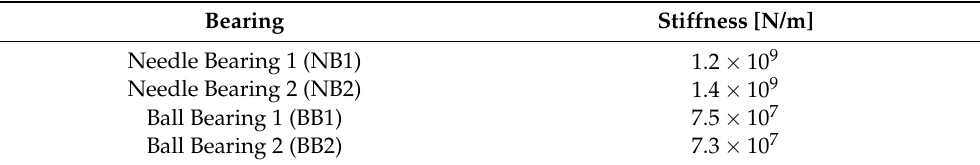
Table 1. Bearing stiffness values.